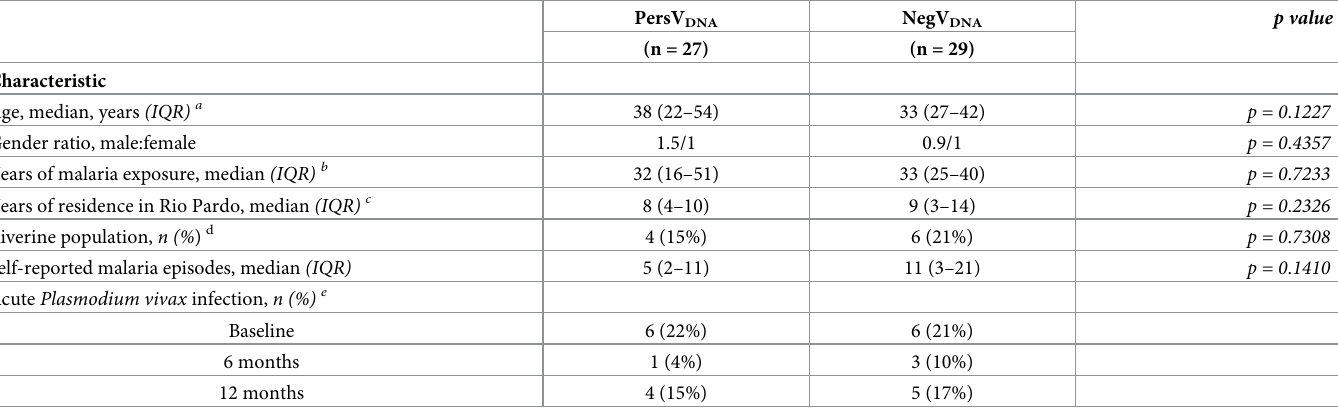
Table 1. Demographic, epidemiological, and parasitological data of malaria-exposed individuals whose EBV-DNA could be detected (PersVDNA) or not (NegVDNA) in the peripheral blood during the 12-month follow-up period. PersV DNA NegV DNA p